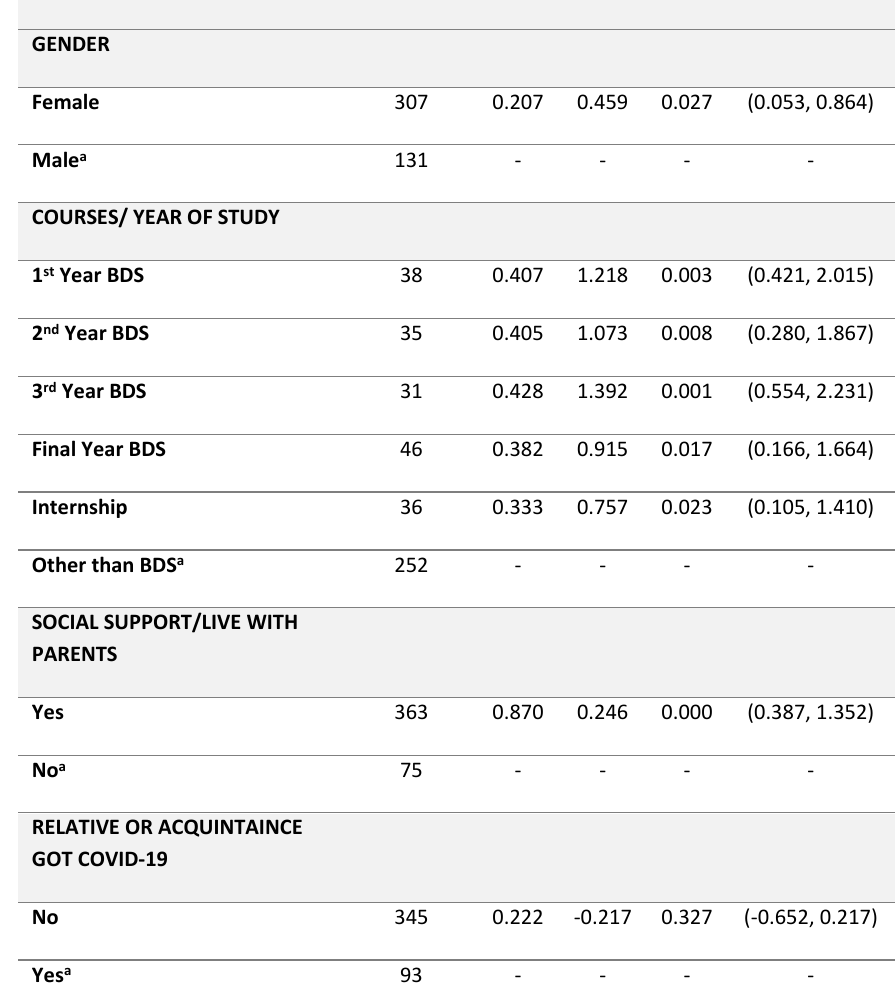
Table 3. Frequency distribution of study participants with different anxiety levels